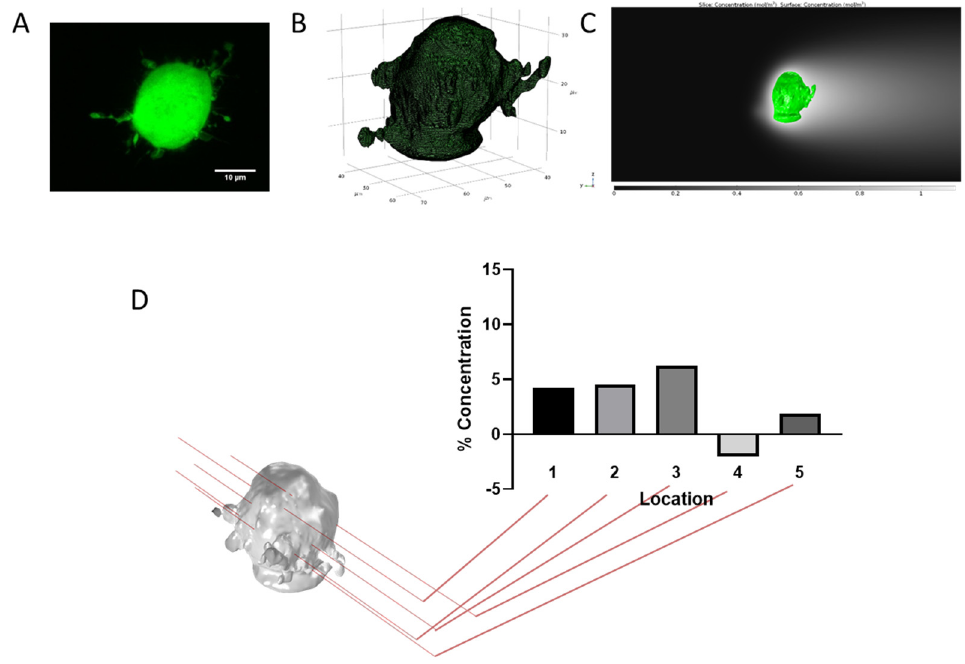
Figure 6. Concentration gradients depend on location along a morphologically accurate tumor cell. ( A ) Confocal image of GL261. ( B ) 3D rendering and mesh used in the model. ( C ) Representative images of cell imports into model and resulting concentration profiles. ( D ) Quantification of % concentration at different points on the cell.